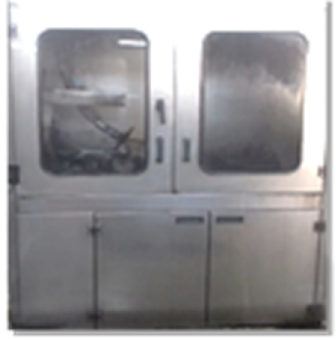
Figure 4. Diesel filters regeneration compact machine.